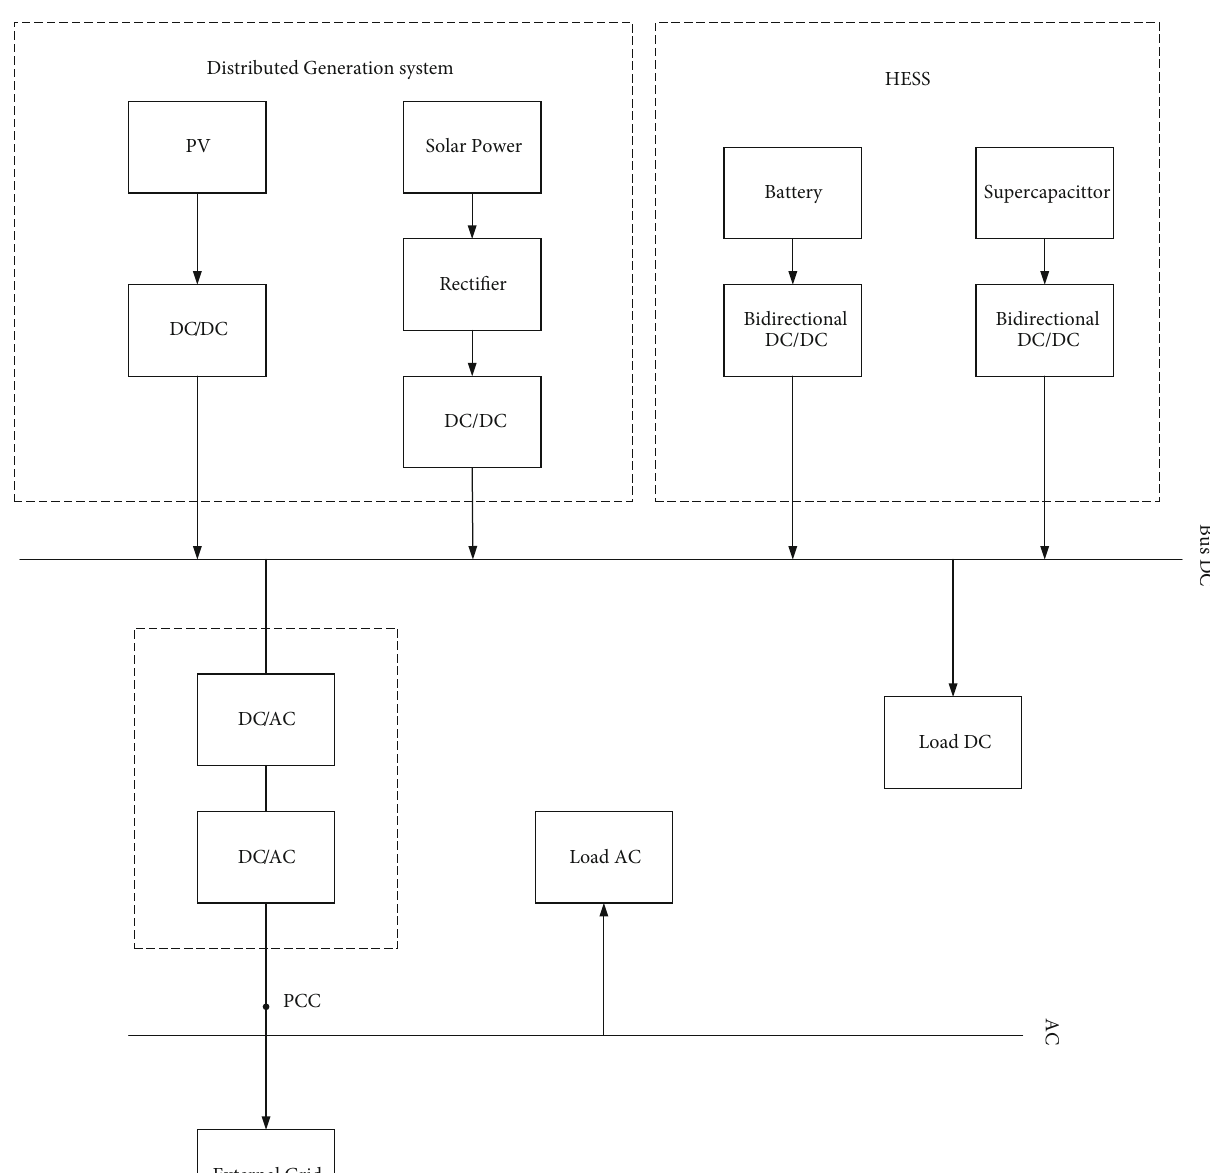
Figure 1: The grid-connected solar hybrid renewable energy production method is depicted in this